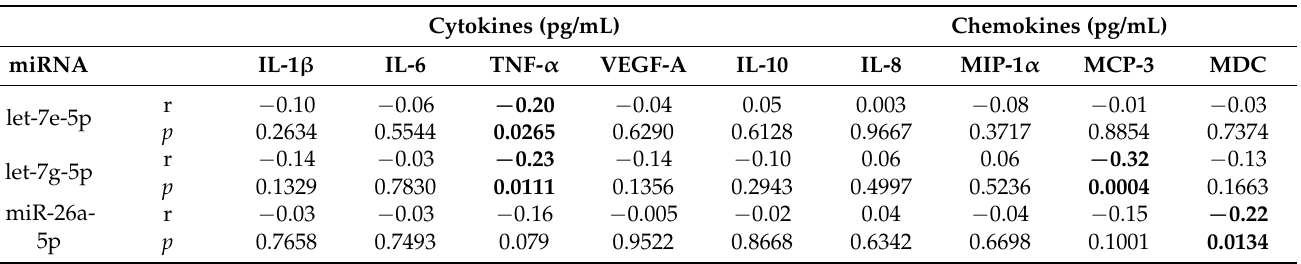
Table 2. Correlations between circulating miRNAs in AMI and serum levels of cytokine and